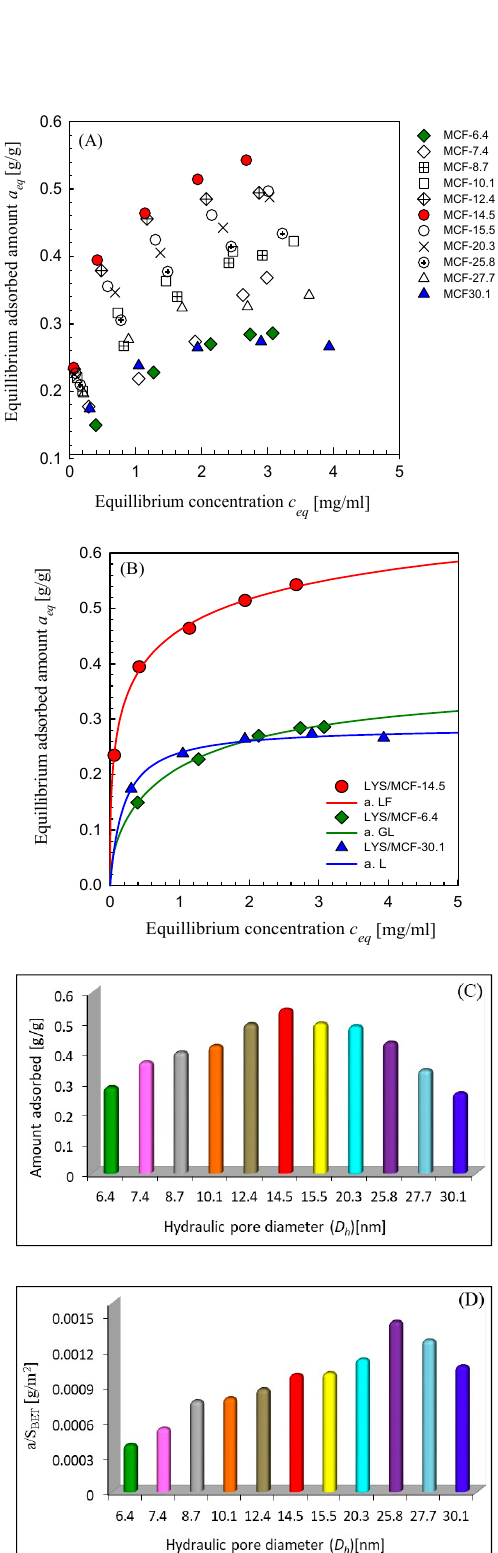
Figure 1. ( A ) Comparison of lysozyme (LYS) adsorption isotherms on mesoporous silica materials with di ff erent pore diameters; ( B ) LYS adsorption isotherms on three selected mesocellular silica foams (MCF) silica materials. Solid lines correspond to the fitted Generalized-Langmuir (GL) isotherm; ( C ) Relationships between the LYS adsorbed amounts, and ( D ) the LYS adsorption density versus the hydraulic pore diameter. Adsorption conditions: the initial concentration of protein solution (c 0 = 5 mg / mL) in phosphate-bu ff ered saline (pH = 7.4) at 25 ◦